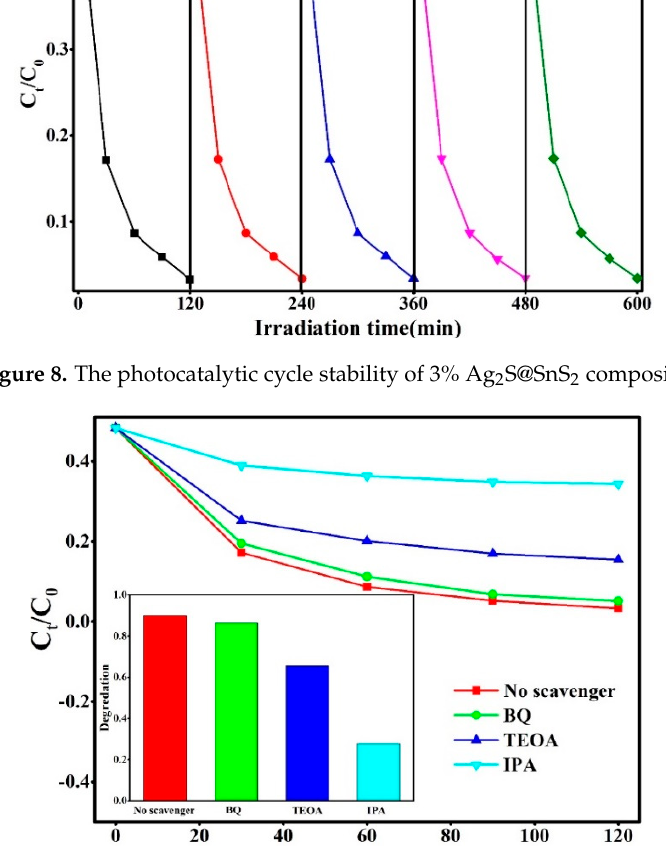
Figure 9. Photocatalytic degradation of 3% Ag 2 S@SnS 2 composite with different capture agents: isopropanol (IPA), benzoquinone (BQ) and triethanolamine (TEOA).